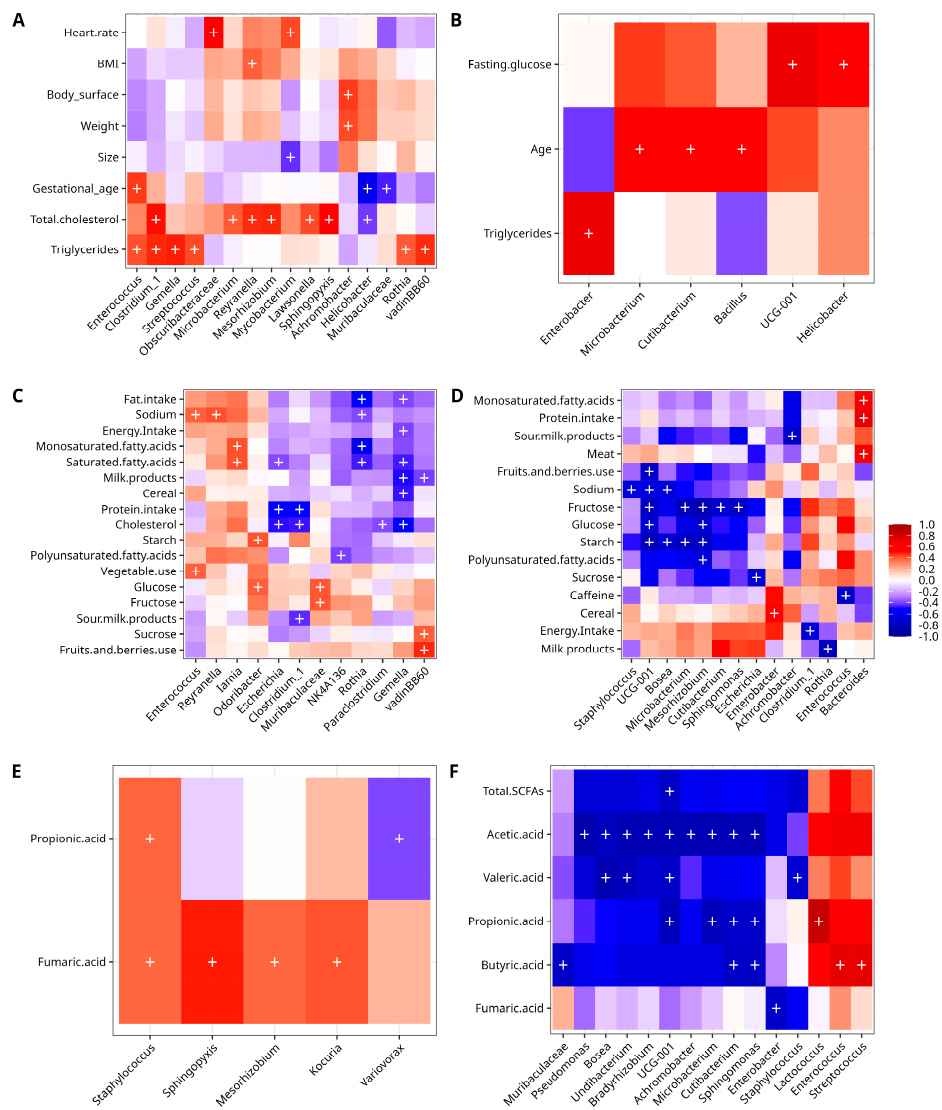
Figure 4. Spearman correlation analysis of clinical data and other variables with bacterial abundance. Anthropometric and clinical for CO ( A ), and GD ( B ); dietary for CO ( C ) and GD ( D ), and SCFA for CO ( E ) and GD ( F ). Columns in the heatmaps show the bacterial taxa, while rows show the numerical metadata. The correlation is measured by the color key from blue ( − 1, negative) to red (+1, positive). The plus symbol “+” denotes a significance of p < 0.001. vadinBB60 (Class